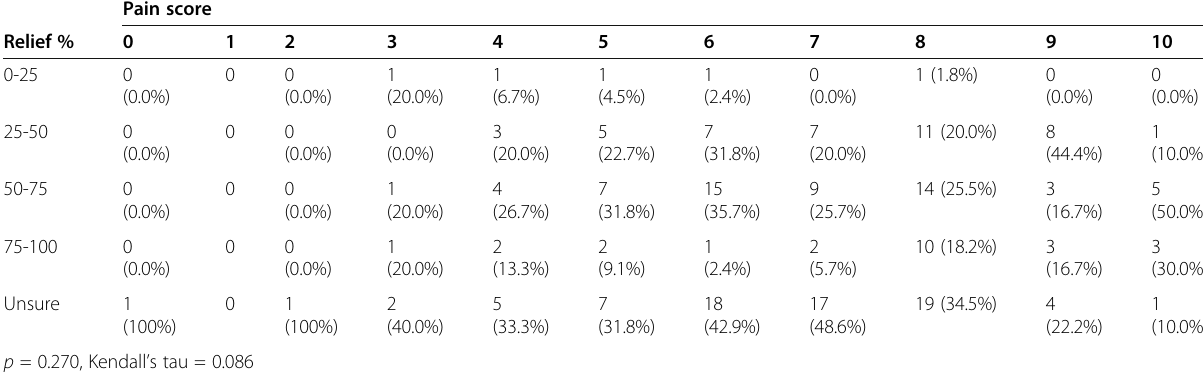
Table 5 Association between Numeric Pain Rating Scale score and expected percentage relief ( n = 204) Pain